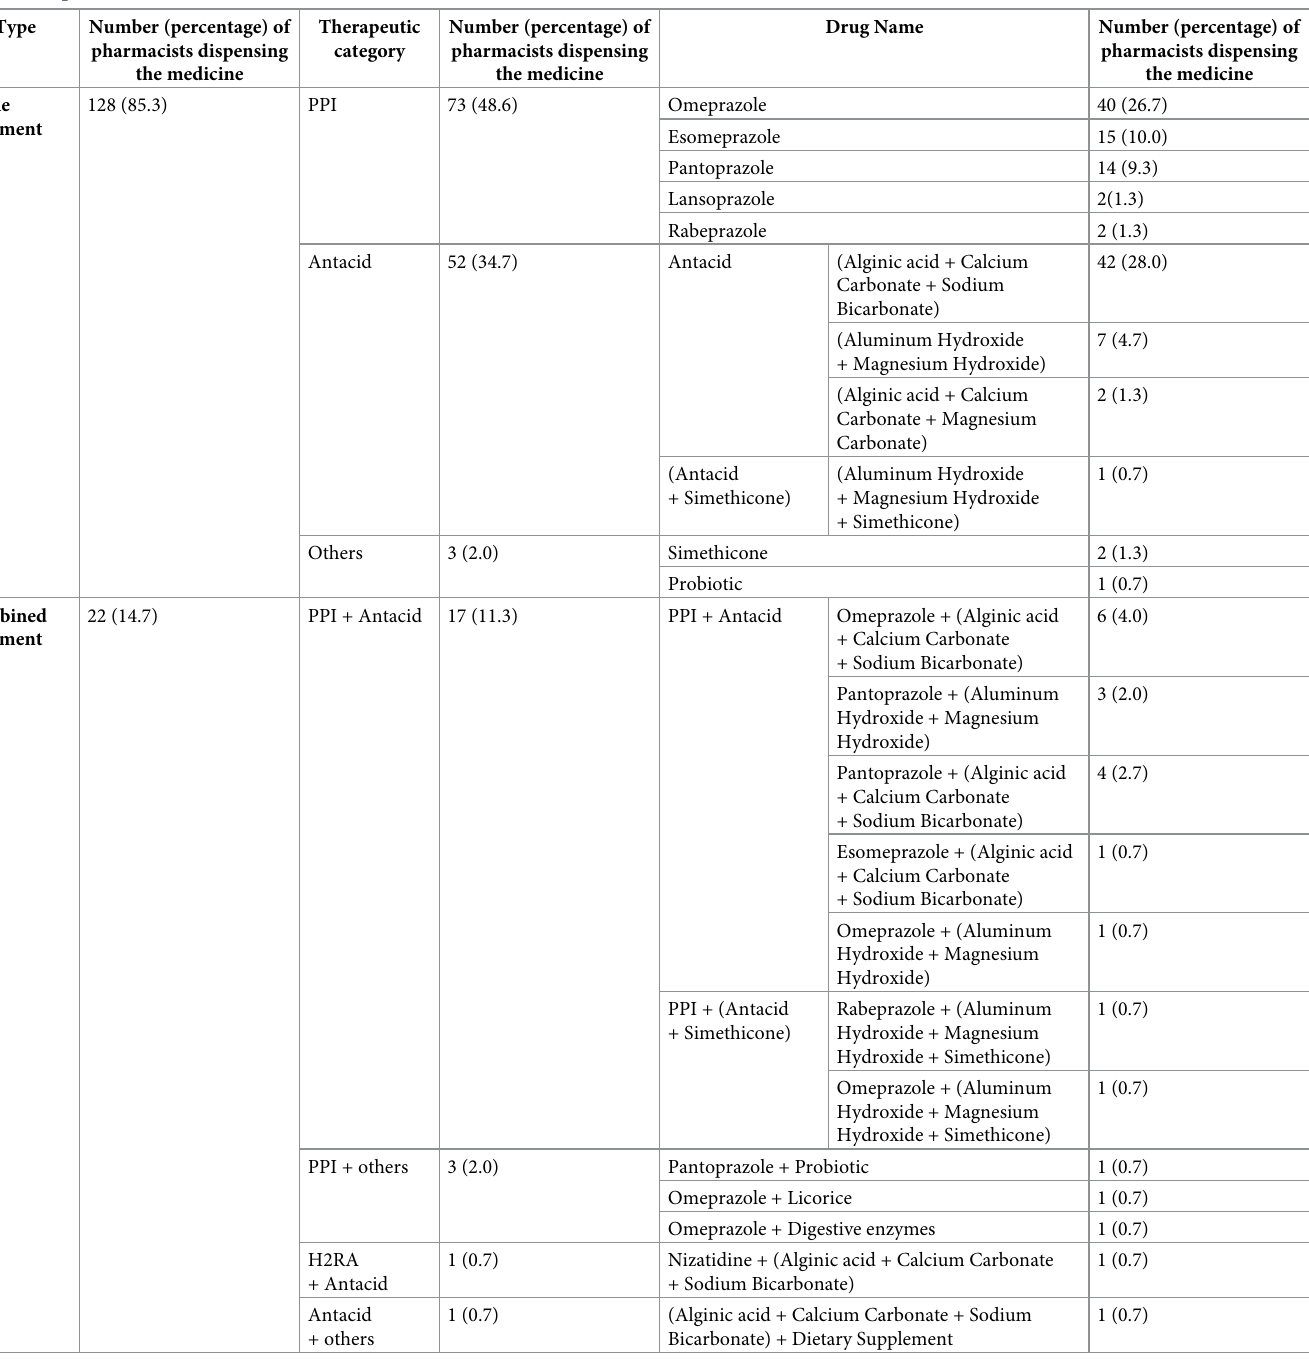
Table 5. Dispensed